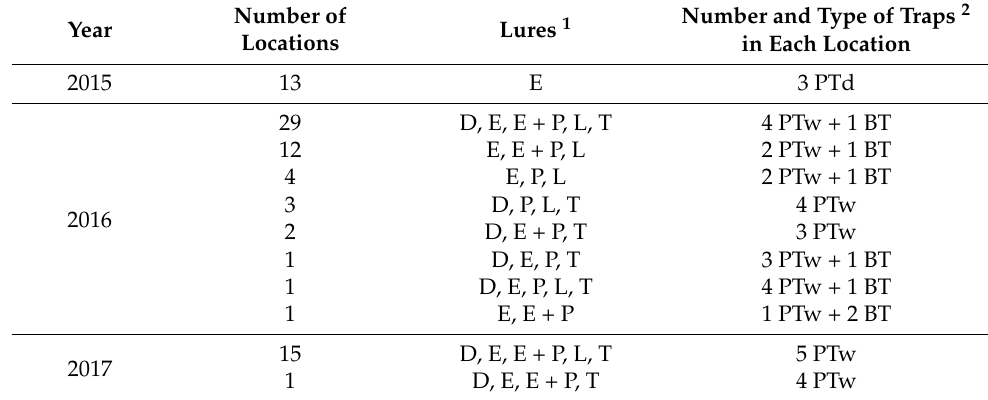
Table 2. The number of locations with different types of traps and